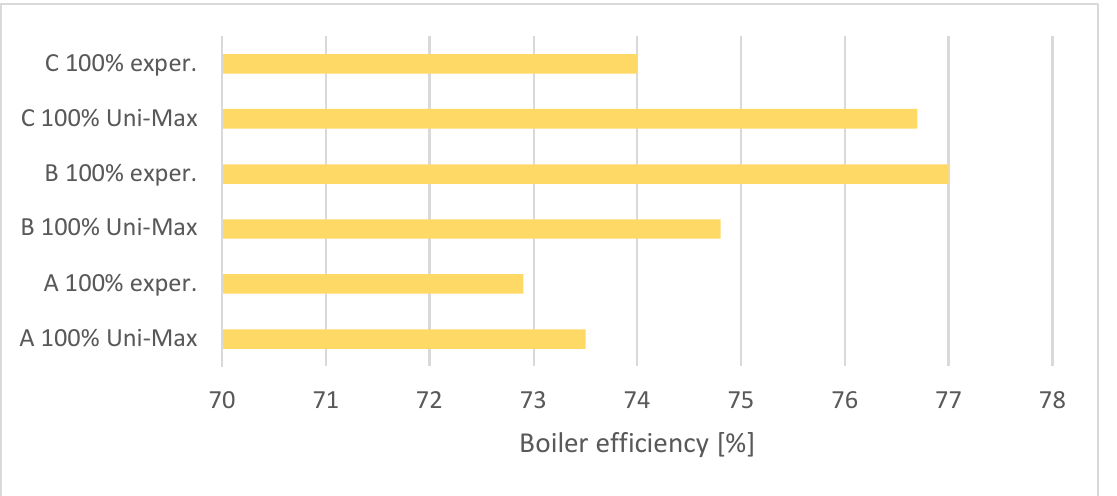
Figure 12. Thermal efficiency of the boiler for two burners when burning three types of commercial wood pellets at full load.